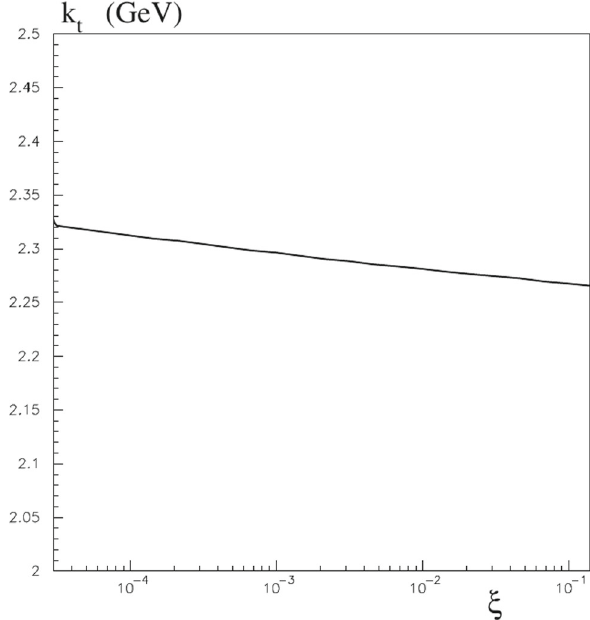
Fig. 10 The t dependence of the SD cross section d σ/ dtdy at 8 TeV and ξ = 10 − 2 . 88 (this value of ξ is chosen to compare with the ATLAS-ALFA [50] results at (cid:8) ξ (cid:9) = 10 − 2 . 88 ). The dashed curve corresponds to the pure Pomeron-induced cross section without the secondary Reggeon contribution